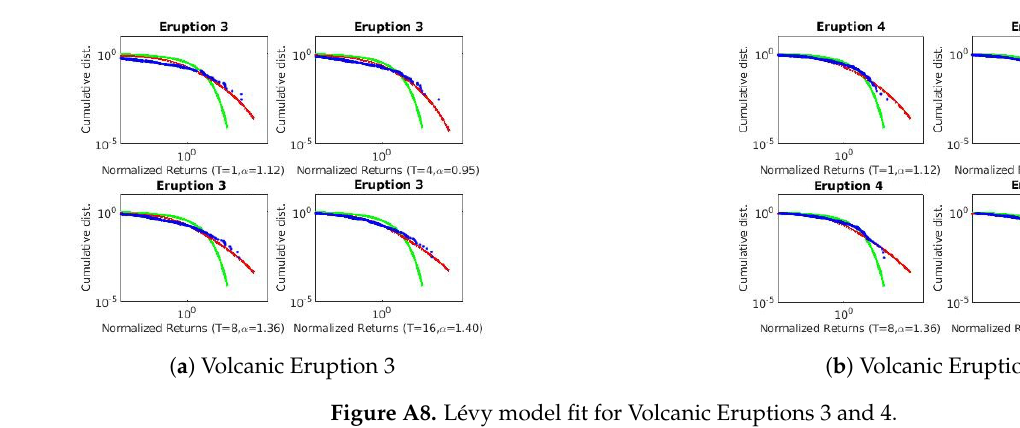
Figure A8. Lévy model fit for Volcanic Eruptions 3 and 4.